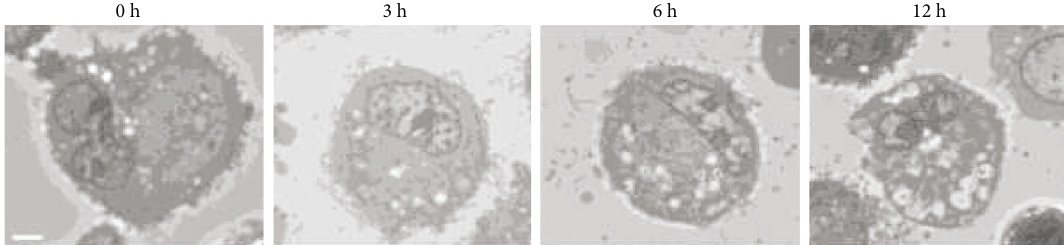
Figure 2: Representative images ( × 1,000) of starved human bone marrow-derived mesenchymal stem cells (hBM-MSCs). Cells were starved in phosphate-bu ff ered saline at room temperature for 0 – 12 h in a previous report [9]. Scale bar = 2 μ m